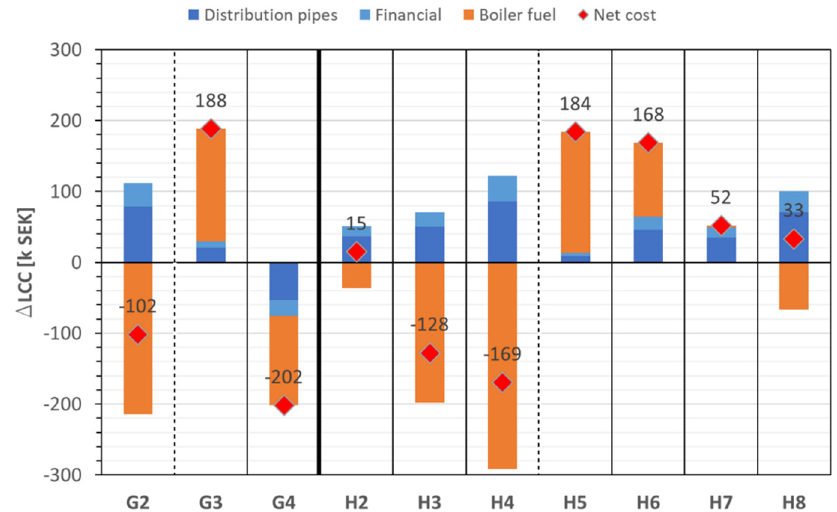
Figure 11. Cost difference—Absolute cost changes for the variants of the GRUDIS and hybrid distribution concept relative to the reference variant (G1 and H1, respectively). The bold line separates variants of different distribution concepts, while the stifled line separates reference pipe manufacturer(s); G2 and H2–H4 employ PEX M2, while G3 and G4 and H5–H8 employ M1 and M3—See Table 6 for an overview.